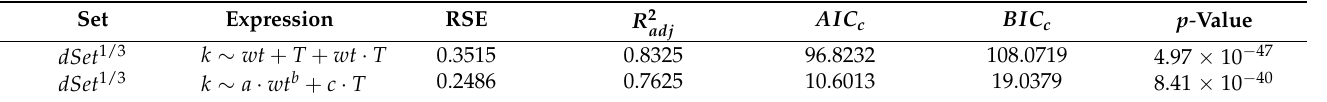
Table 7. Best regression results for k as a function of w t and T for the CMC